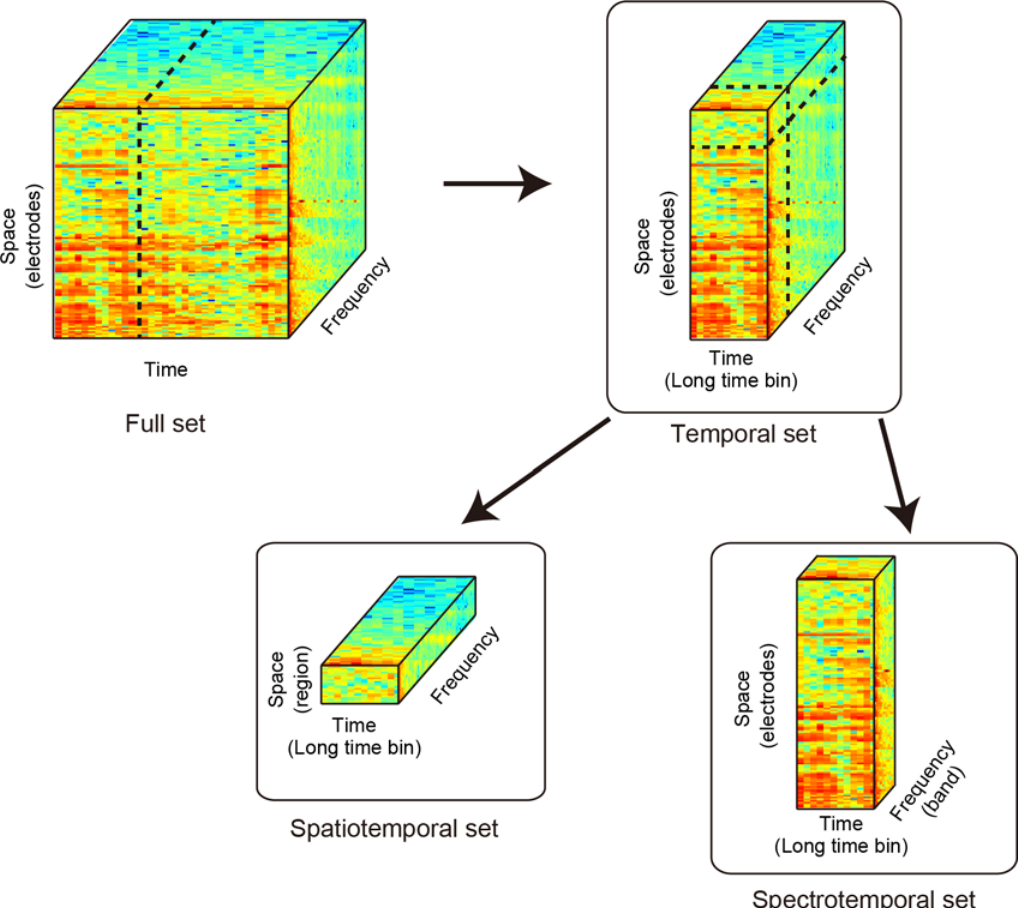
Fig 3. Schematic illustrations of the ECoG feature subsets. This figure shows how the tensor of the power spectrum of ECoG data was constructed. The ECoG feature tensor had three dimensions: space, time, and frequency. We named these three types of ECoG feature subsets (1) the temporal set, (2) the spatiotemporal set, and (3) the spectrotemporal set. Each ECoG feature subset was vectored for each trial and was used to construct social decoders to discriminate the social conditions. The accuracies of the social decoders were compared to identify which ECoG features contained information about the social